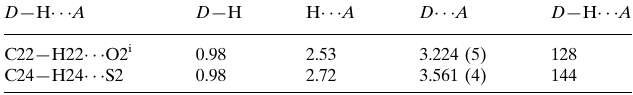
Hydrogen-bond geometry (A˚ , (cid:2)